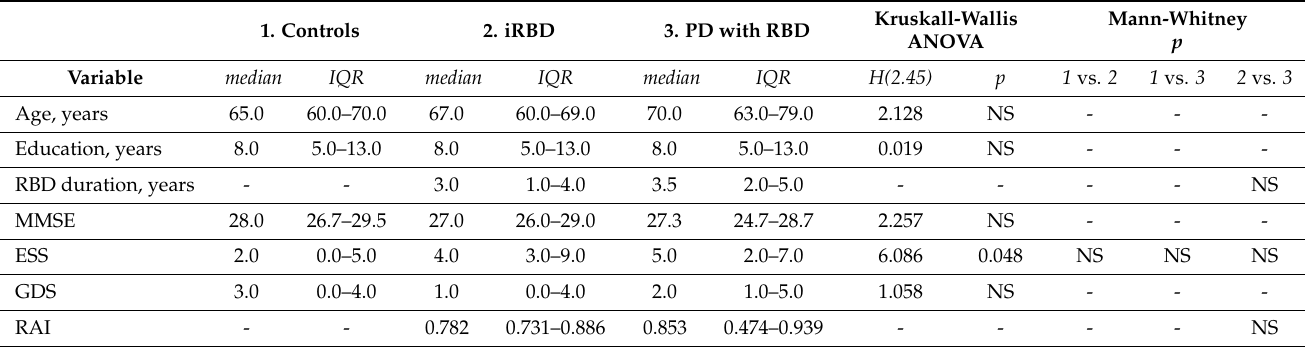
Table 1. Demographic and clinical characteristics of the three groups of